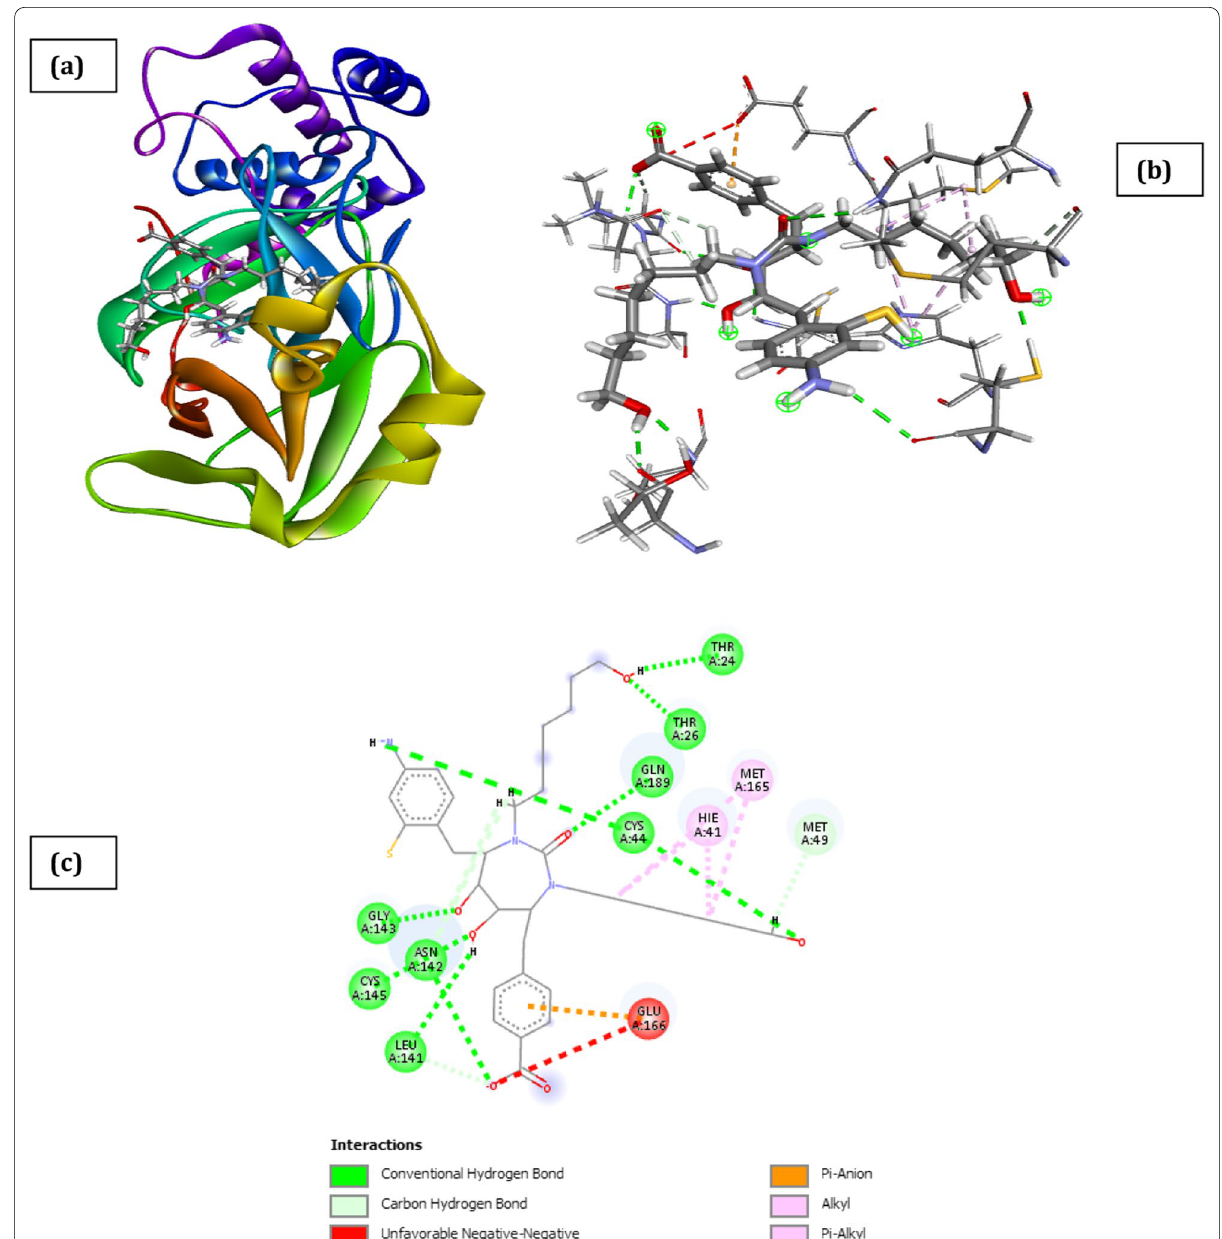
Fig. 8 Docked poses of SARS CoV 2 main protease (PDB ID: 6XBH) with inhibitor with Index number 46d (stick figure) a 3D view of docked pose of SARS CoV 2 Main Protease (PDB ID: 6XBH) with inhibitor with Index number 46d b 3D view of inhibitor with Index number 46d with surrounding amino acids of 6XBH; c 2D view of interaction type of inhibitor with Index number 46d with surrounding amino acids of